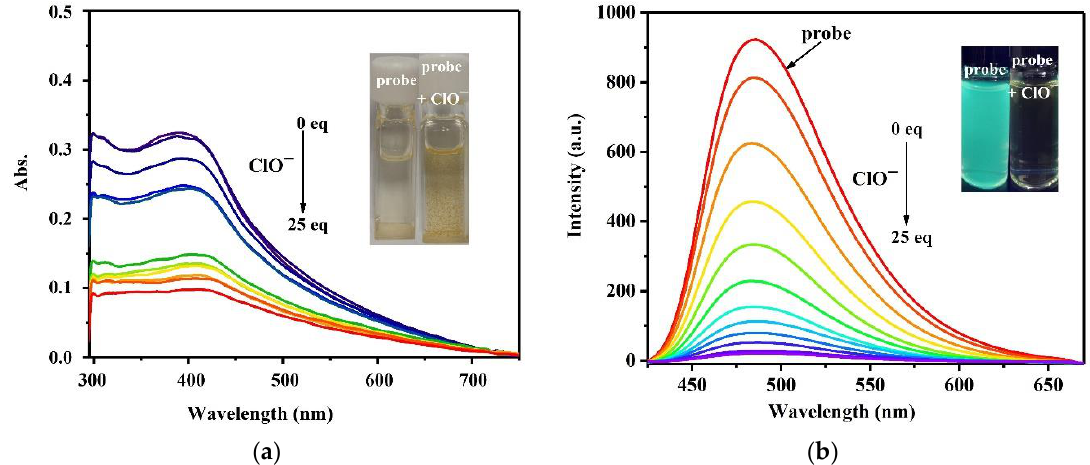
Figure 3. Absorption ( a ) and emission ( b ) titration spectra of the probe TPE4A (40 µM) in the presence of various concentrations of ClO − from 0 to 25 equivalent in mixed solution ( f w = 80%). Inset: the contrastive pictures before and after the addition of ClO − .